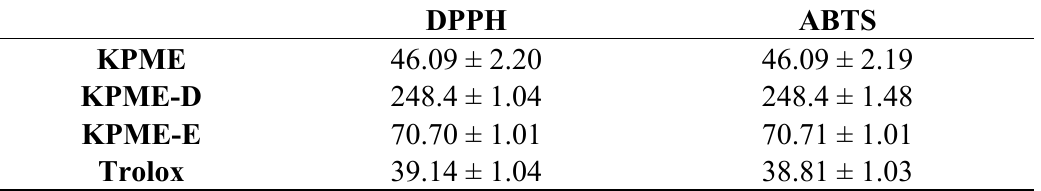
Table 1. Radical Scavenger Activity of K. pauciflora roots